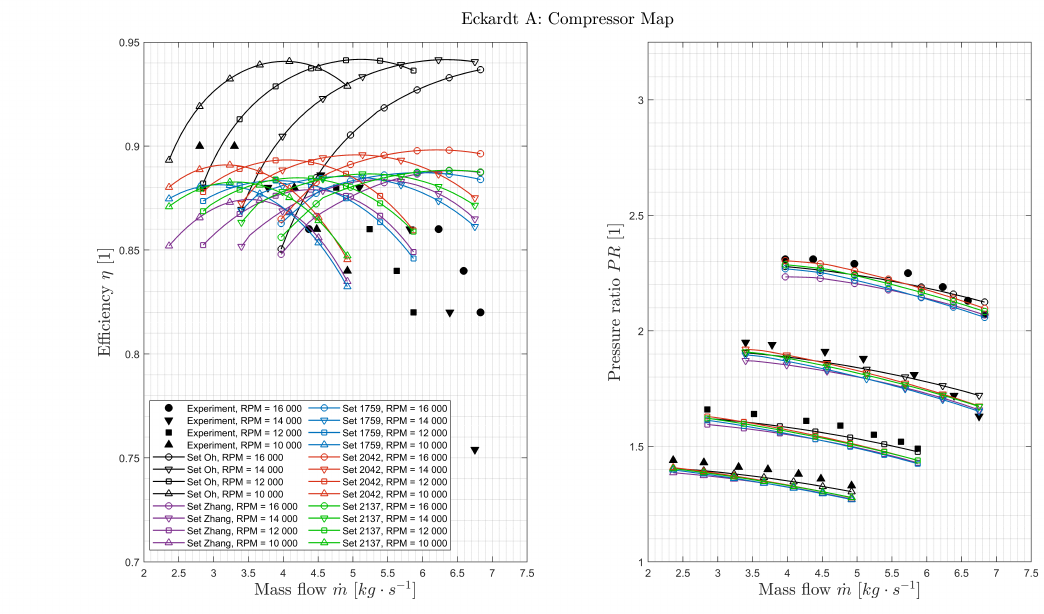
Figure 12. Eckardt A compressor map for chosen loss model sets in comparison to experimental data: ( left ) Efficiency; ( right ) pressure